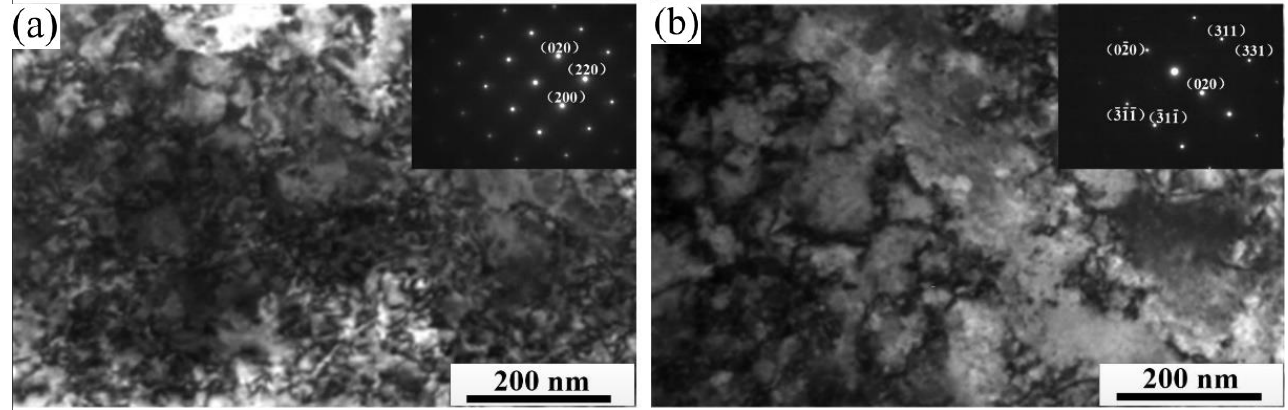
Figure 6. Dislocation structure of cold rolled strip (ε = 25%) ( a ) EG strip; ( b ) CG strip. When the deformation amount of the strip is 50%, shear zones appear in both strips, which only develop inside the grain and fail to cross grain boundaries, as shown in Figure 7. The distribution of the shear zone in the EG strip is not uniform, the direction is not consistent, and local uneven deformation becomes more severe. The shear bands of the CG strip are evenly distributed in the same direction, and the angle is 30 ◦ to the rolling